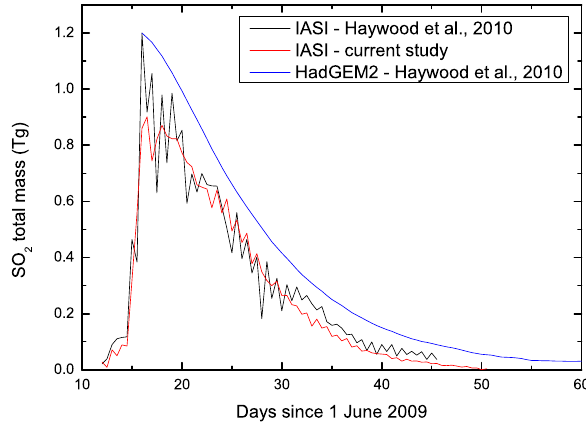
Fig. 10. Time series of SO 2 measured with IASI: original study (Karagulian et al., 2010) in blue, current reanalysis in red and OMI (Krotkov et al., 2010) in black.